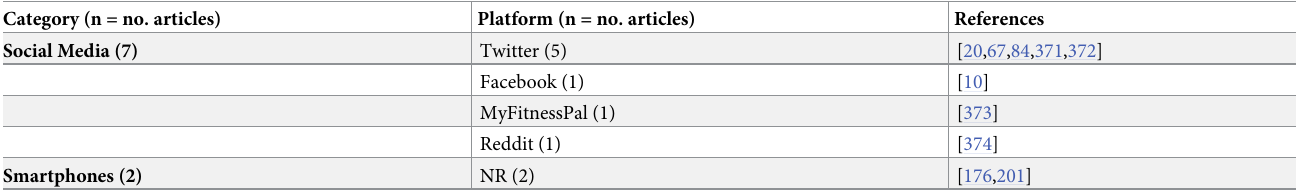
Table 25. Number of articles predicting health, with associated predictors and references.